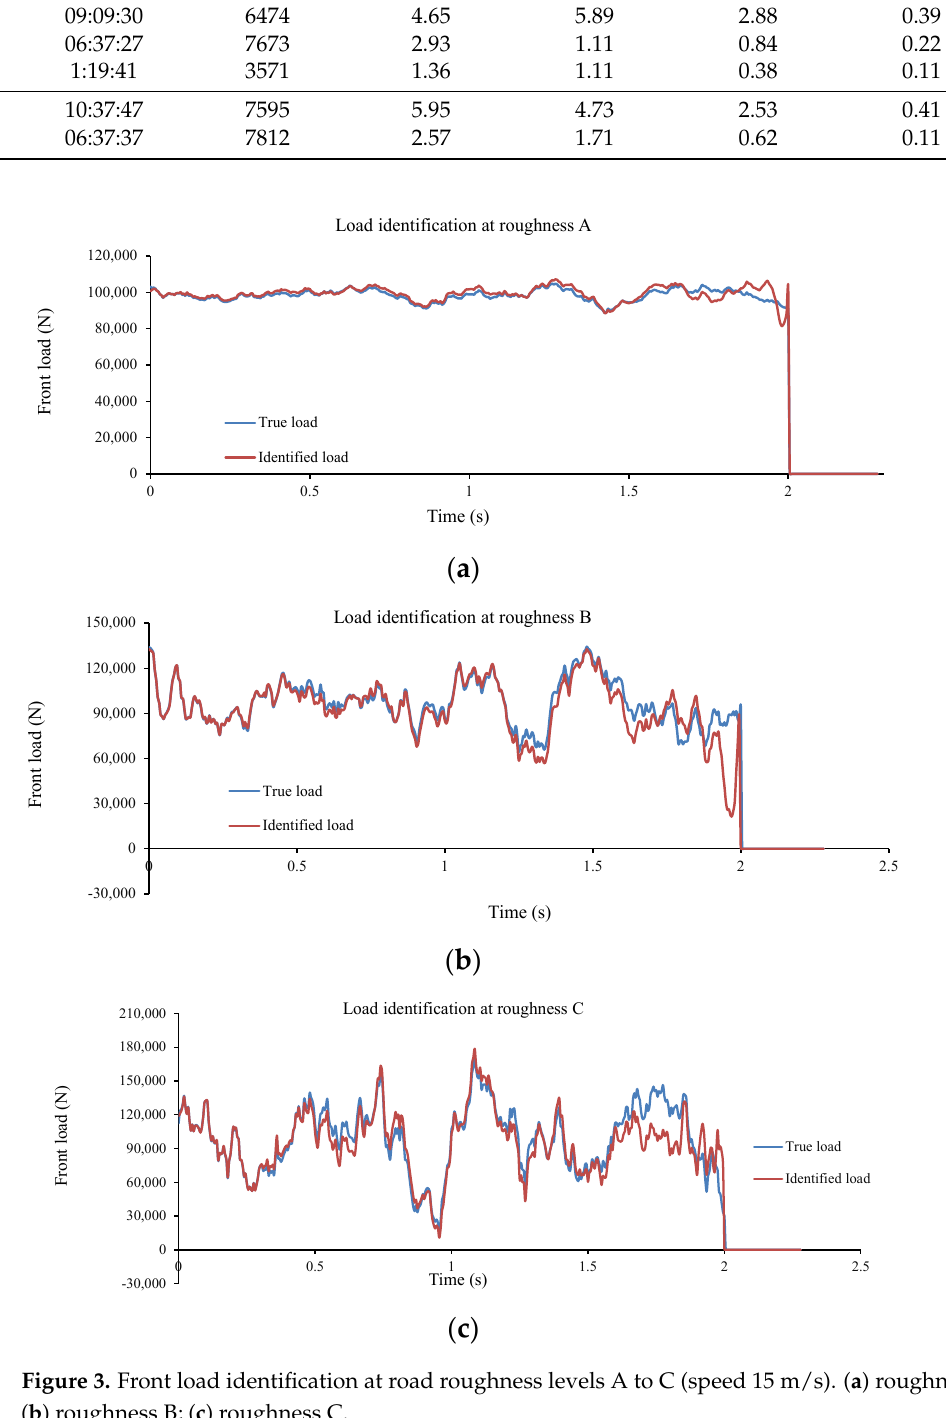
( b ) roughness B; ( c ) roughness C.